Question: Which visualization type does this figure use?
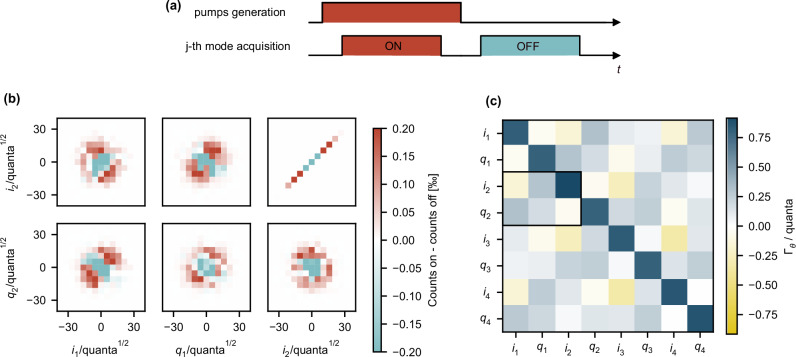
Answer: histogram